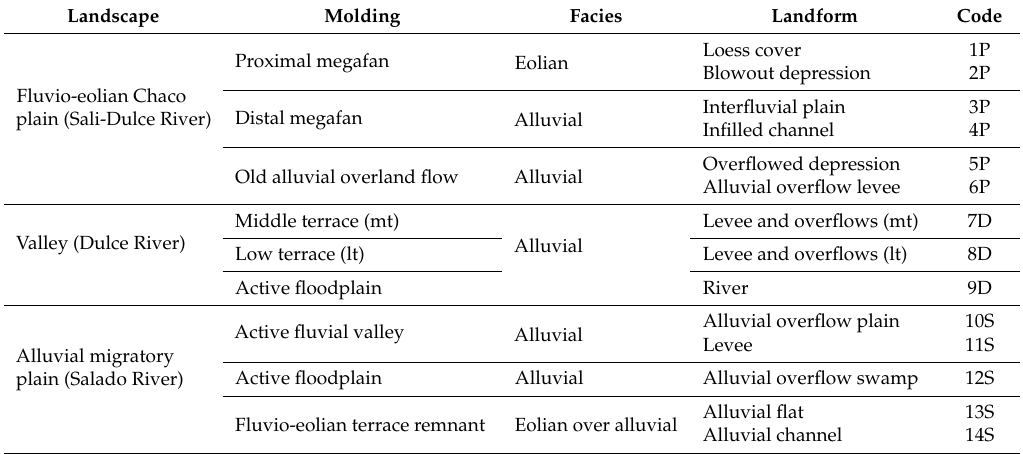
Table 1. Ground-truth information obtained from a geopedologic survey